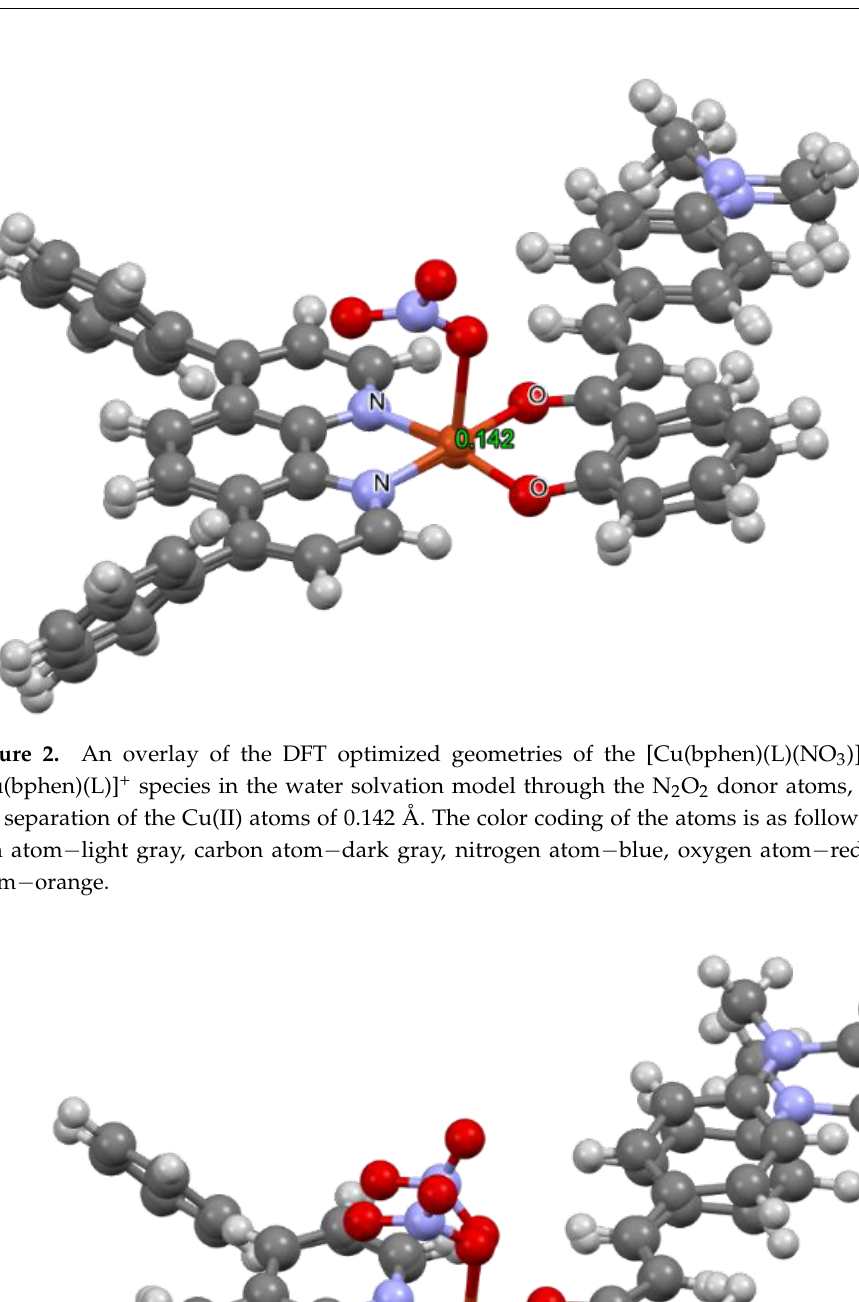
9 of 19 Figure 1. The geometries of the [Cu(bphen)(L)(NO 3 )] ( 2 ) ( left ) and [Cu(bphen)(L)] + ( right ) species optimized in a water solvation model at the  B97X-D/def2-tzvp level of theory. The color coding of the atoms is as follows: hydrogen atom−light gray, carbon atom−dark gray, nitrogen atom−blue, oxygen atom−red, copper atom−orange. The similarities on one side and differences on the other side of both structures cal- culated using the water solvation model can be seen in Figure 2, which depicts an overlay of both molecules over the N 2 O 2 donor atoms. As expected, the copper(II) atom was situ- ated in the square-pyramidal geometry of [Cu(bphen)(L)(NO 3 )] ( 2 ) 0.142 Å above that in the square-planar geometry of [Cu(bphen)(L)] + . However, some of the interatomic param- eters within the square-pyramidal polyhedra between the DFT calculated structure of [Cu(bphen)(L)(NO 3 )] and the X-ray determined structures of [Cu(phen)(L)(NO 3 )] [this work] and [Cu(phen)(chal1)(NO 3 )] [8] also differed significantly. Thus, we performed ad- ditional calculations using the water solvation model with the aim to create more realistic conditions influencing the final coordination geometry of the studied compounds. The results revealed that the selected interatomic parameters around the copper(II) atom be- tween the DFT calculated geometry and those determined experimentally were very close to each other, and thus the calculations at the  B97X-D/def2-tzvp level of theory using the water